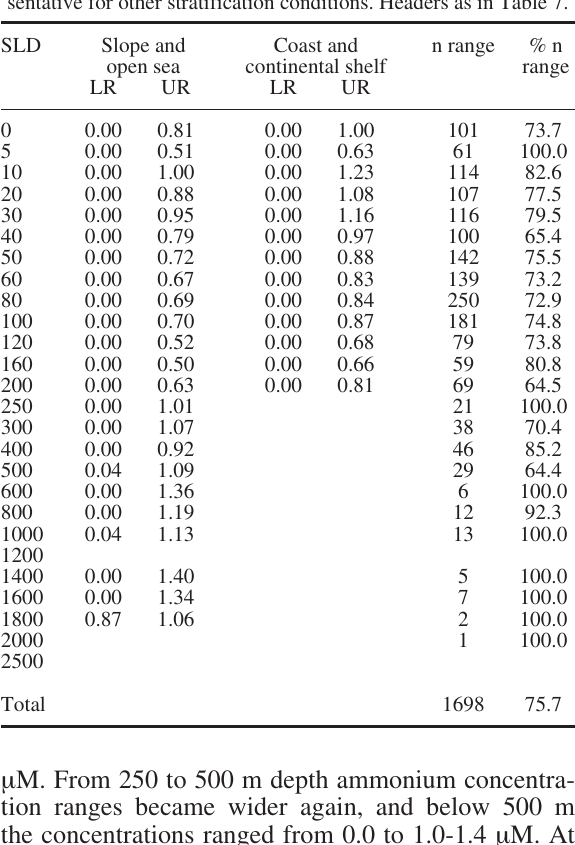
Table 12. – Ammonium concentration ( m M) ranges in the NW Mediterranean Sea in stratified water columns (stratification coef- ficient = 2, 3 and 4). Below 500 m depth, data was gathered only from stations with stratification index 2, so they could not be repre- sentative for other stratification conditions. Headers as in Table 7.